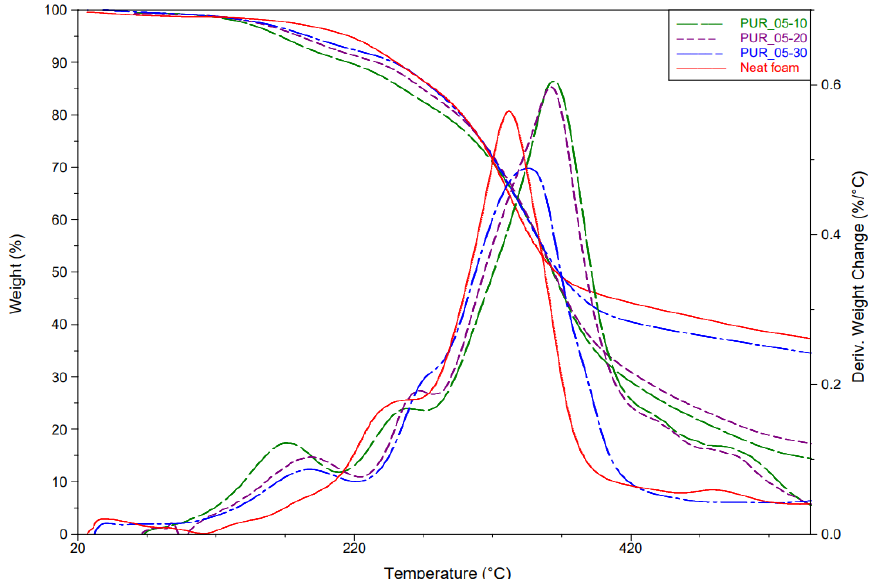
Figure 4. Effect of the wood flour reinforcement on TG and DTG of the reinforced polyurethane foams.